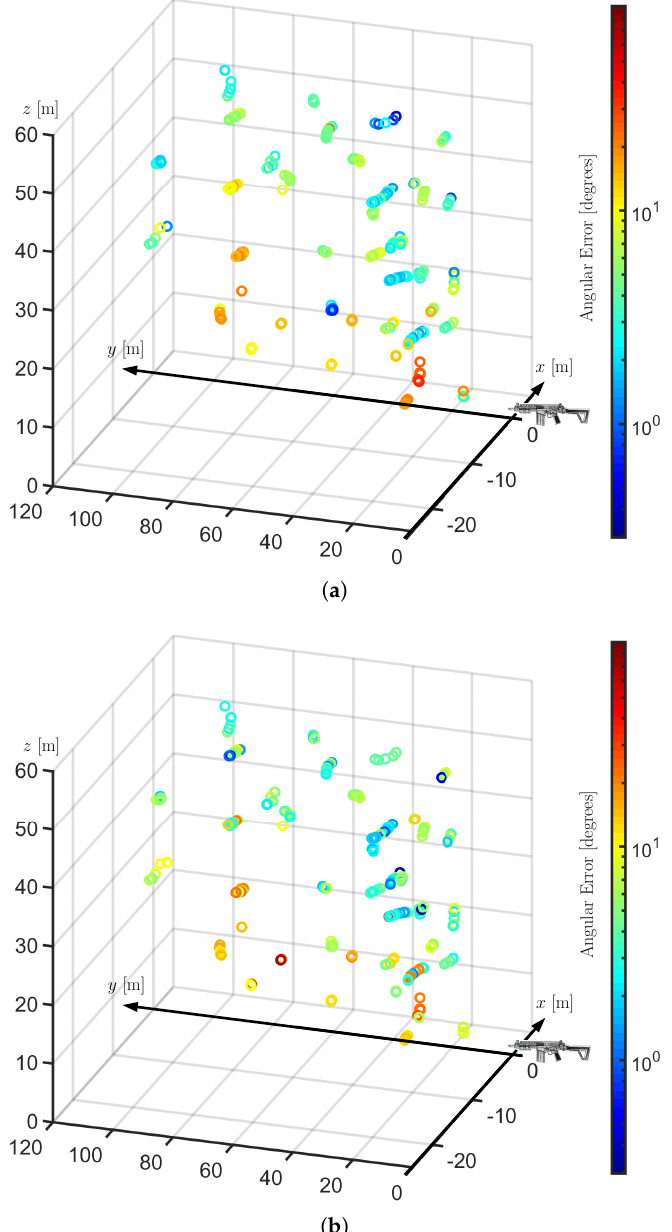
Figure 8. Positions of the drone and respective DoA angular errors: Note that the greater errors (warmer colors) correspond to a region in front of the muzzle. ( a ) Results of the Least Squares method with median filtering. ( b ) Results of the MBSS method without